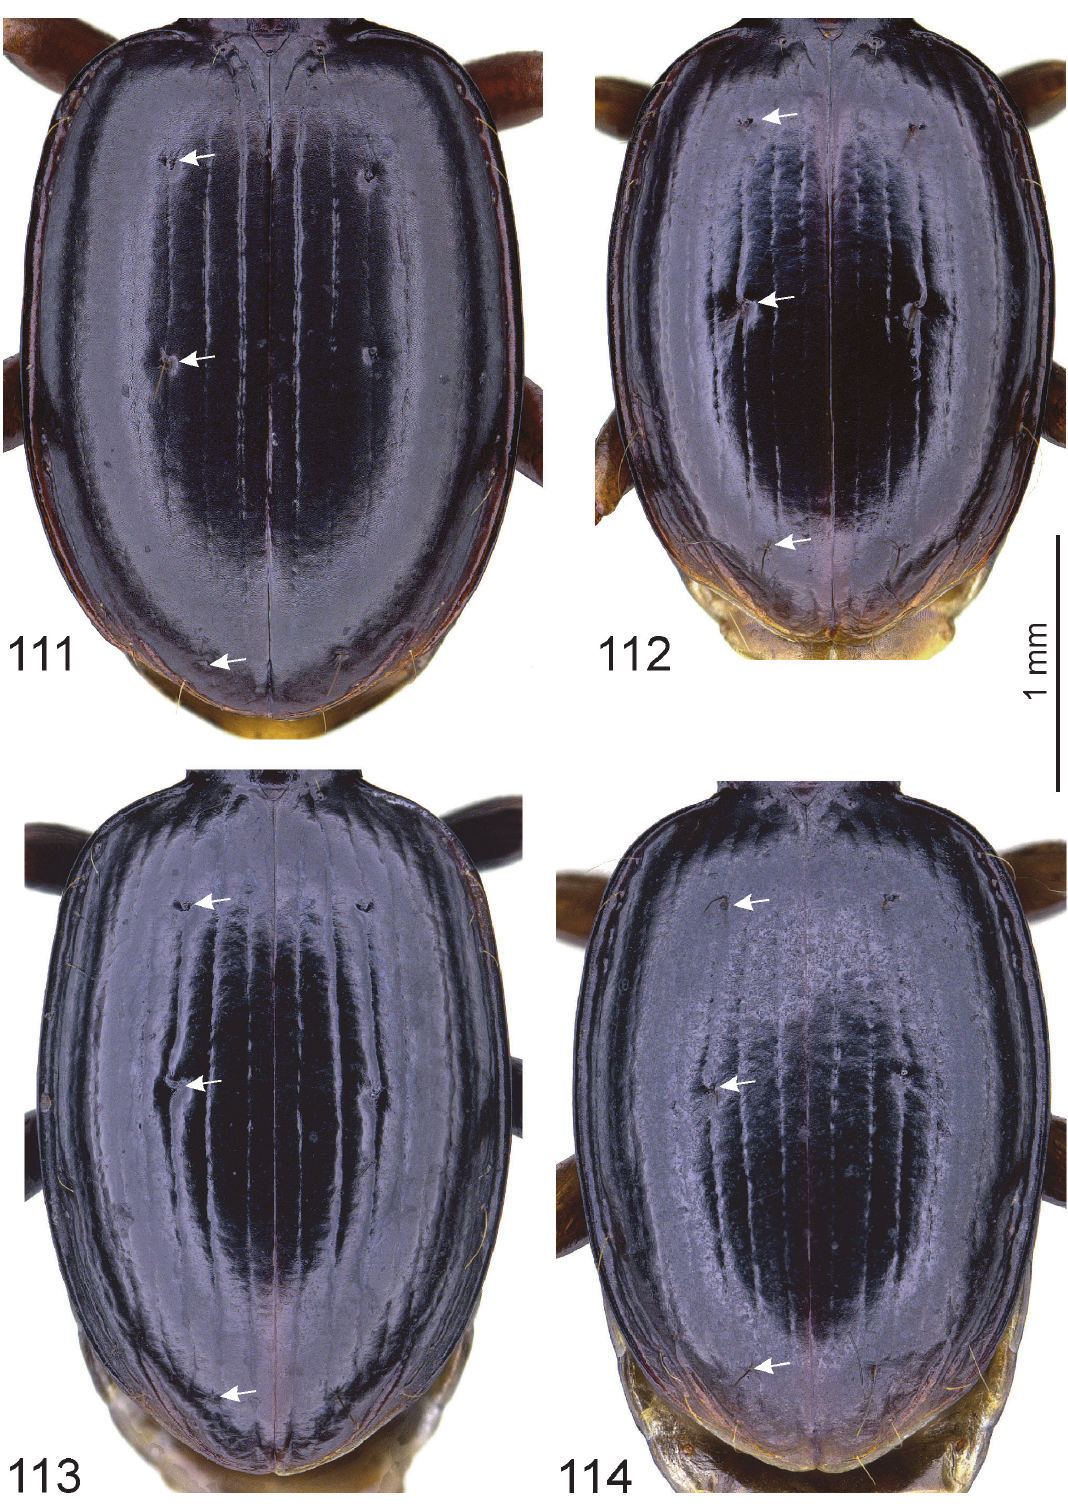
Figs 111–114. Trechus spp., elytra. 111 . T. haggei sp. nov., paratype, ♂. 112 . T. tragelaphus sp. nov., holotype. 113 . T. nigrifemoralis , sp. nov., holotype. 114 . T. balesilvestris , sp. nov., holotype. The arrows point to the insertions of the discal setae and the preapical